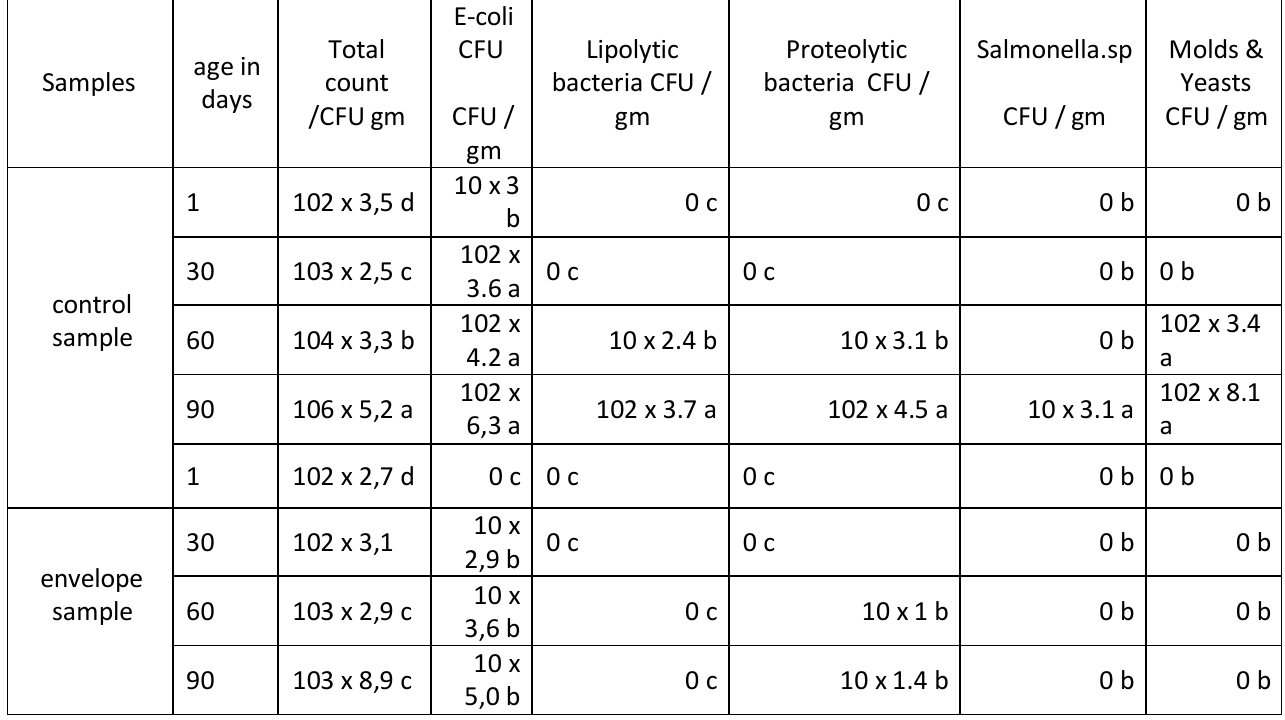
Mean ± SD. Having different superscript letters on columns are significantly different